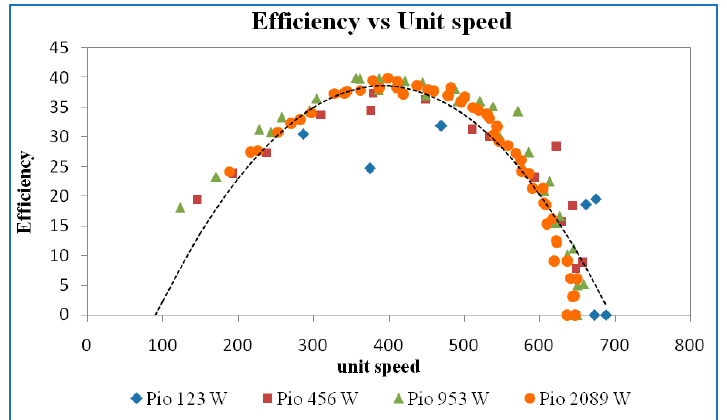
Figure 30. Efficiency vs. unit speed at a guide vane opening of 13 mm. For a guide vane opening of 16 mm, the unit discharge versus unit speed curve is shown in Figure 31. The unit discharge decreases with an increase in unit speed.